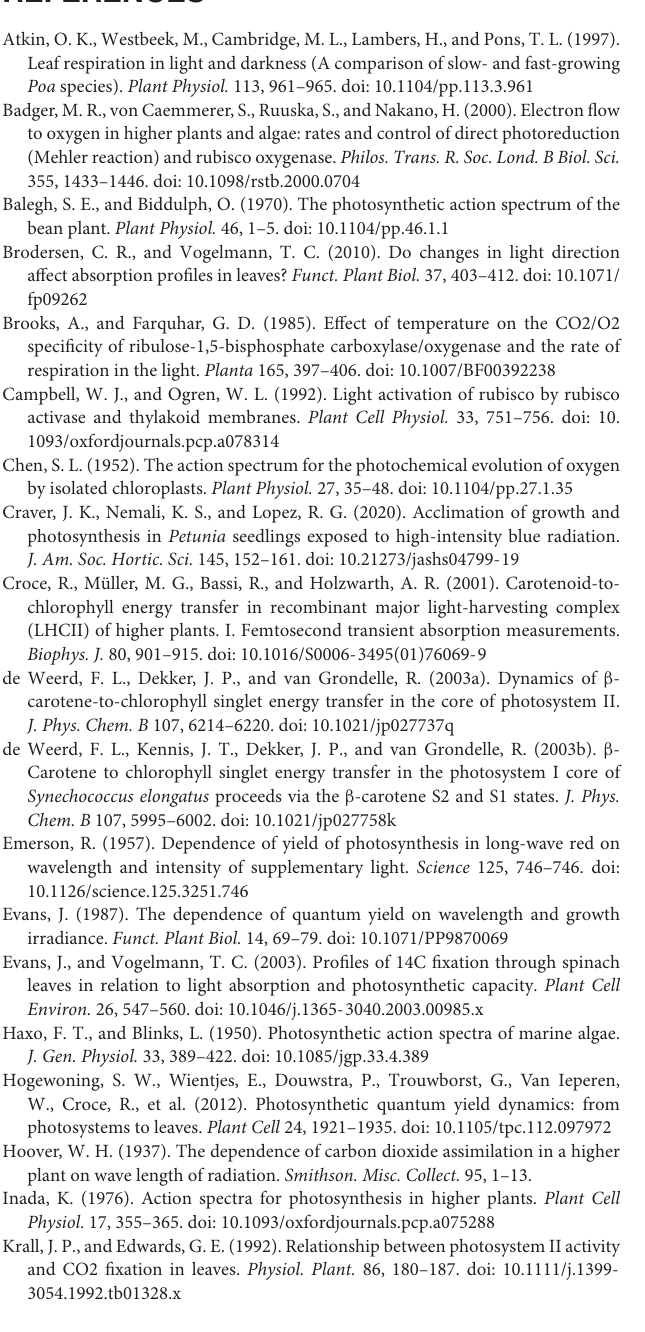
Supplementary Figure 4 | (Related to Figure 6 ) The comparison between QY inc before (A) and after (B) correcting for light-suppression of respiration under blue, green, and red LED light. Note that the initial increase in QY inc became more pronounced after correction of light suppressed respiration. Supplementary Figure 5 | The comparison between QY abs before (A) and after (B) correcting for alternative electron sinks under blue, green, and red LED light. Assuming a simplified electron sink that diverts energy of 15 µ mol m − 2 s − 1 of absorbed photons (an arbitrary value used for illustrative purposes only) away from the Calvin cycle under all PPFD s, the corrected QY abs was calculated based on